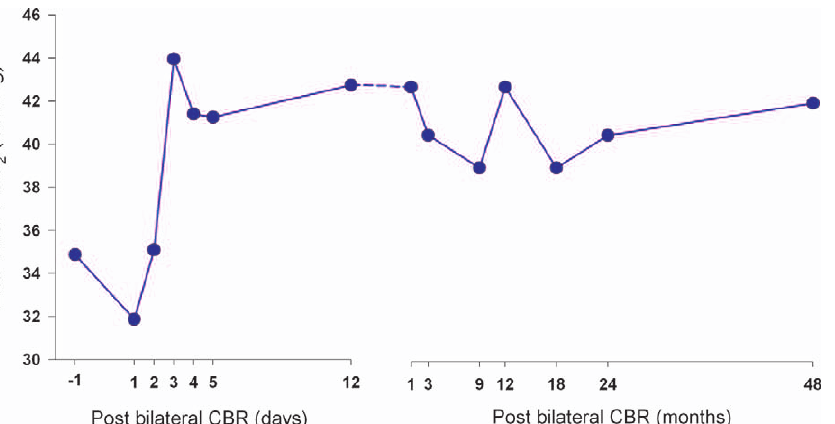
Figure 4. Resting P ET CO 2 Values Observed on Days 1–5 after Bilateral Resection of the Carotid Bodies and Subsequent Days of Testing in Patient 1 The lower P ET CO 2 values on postoperative day 1 may reflect anesthesia- or analgesia-induced lowering of metabolism. The subsequent rise in resting P ET CO 2 is related to the loss of the peripheral chemoreceptors and the effect of this loss on the central